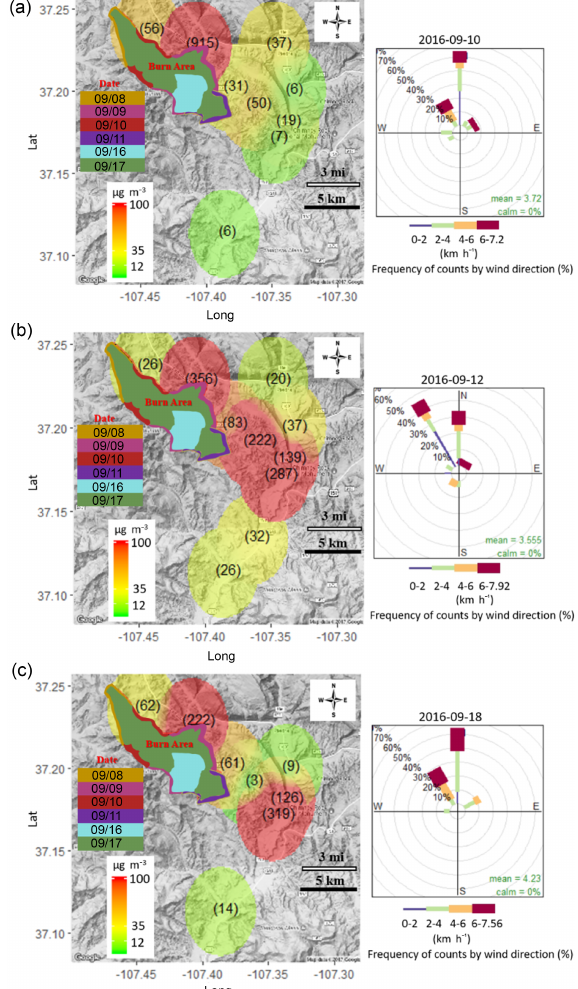
Figure 7. Maps illustrating spatial concentration gradients and the temporal evolution of fire emissions for (a) 10 September, (b) 12 September, and (c) 18 September 2016. Numbers indicate 24h average mass concentration at each sampling site (e.g., “57” refers to a 24h mass concentration of 57µgm − 3 ). Dates represents the location and area burned each day with respect to the total pre- scribed